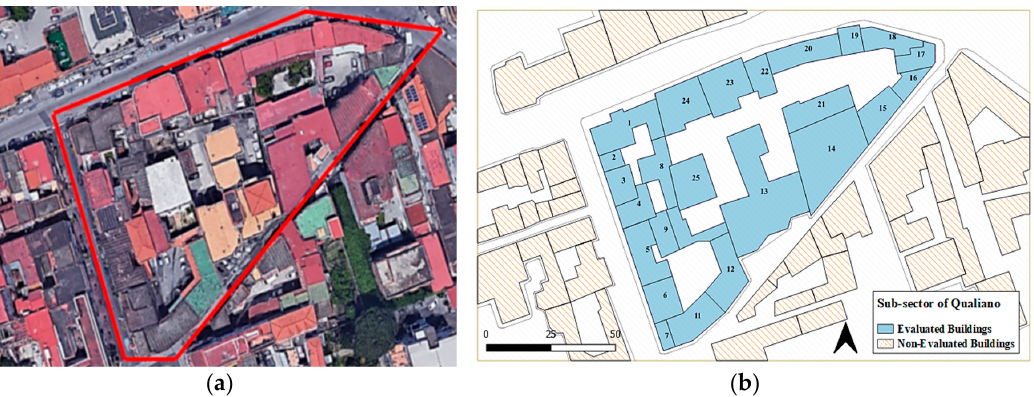
Figure 3. ( a ) Bird-eye view and ( b ) numbering of buildings in the selected sub-sector of the C01 sector.